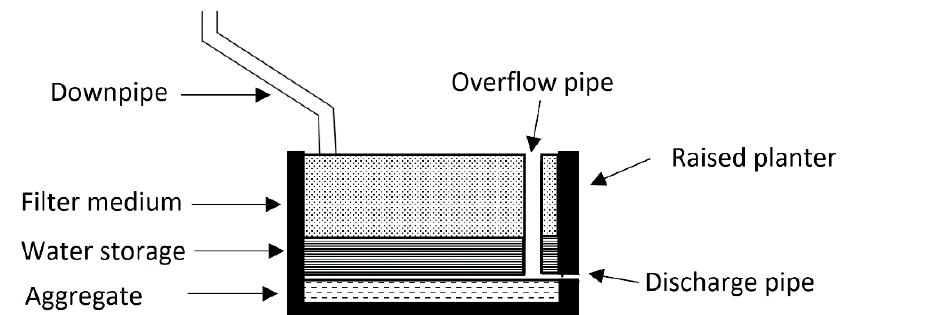
Figure 5. Schematic of the rainwater planters installed in two rear-yards on Poplar Street. Each planter contained a filter medium and storage compartment to filter and attenuate roof run-off and reduce flow into the drainage network.